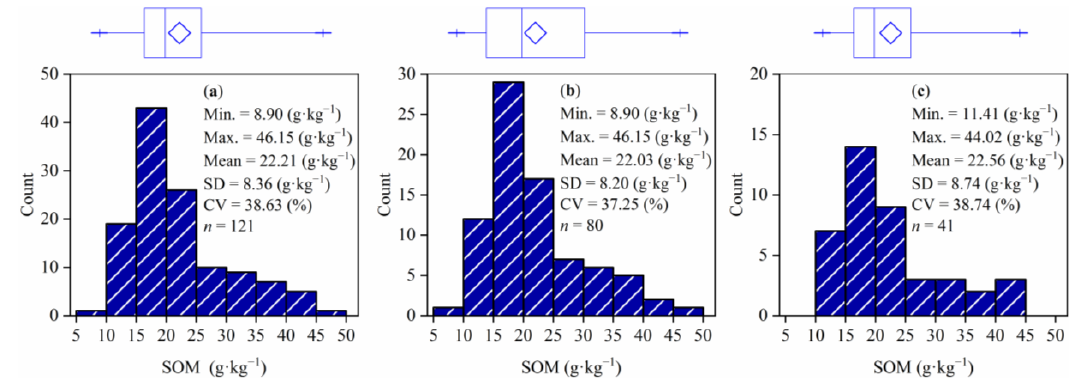
Figure 3. Box-plots, histograms and descriptive statistics of SOM: ( a ) the whole dataset; ( b ) calibration dataset; and ( c ) independent validation dataset. Min.: minimum, Max.: maximum, SD: standard deviation, CV: coefficient of variation, n : the number of soil samples.